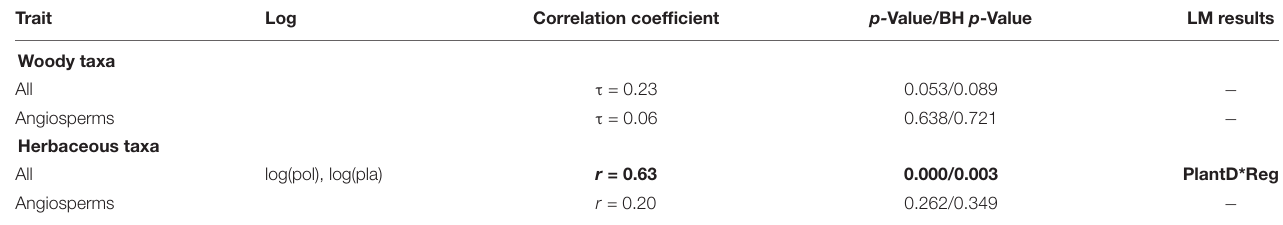
TABLE 4 | Correlation test results between pollen and plant based phylogenetic